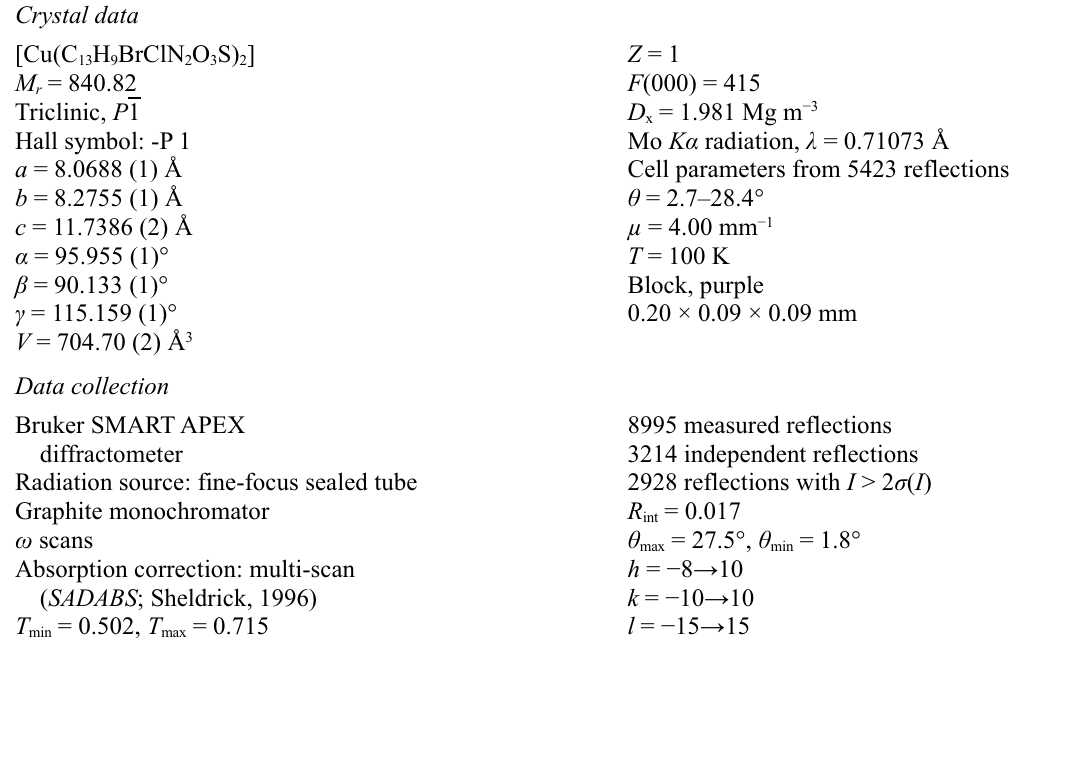
Figure 1 Thermal ellipsoid plot (Barbour, 2001) plot of Cu(C drawn as spheres of arbitrary radius. Hydrogen bonds are denoted by dashed lines. The copper atom lies on a center of inversion, and unlabeled atoms are related to their labeled equivalents by 1 – x , 1 – y , 1 – z . Bis{2-bromo-4-chloro-6-[2-(phenylsulfonyl)hydrazonomethyl]phenolato- κ 2 N , O 1 }copper(II) Crystal